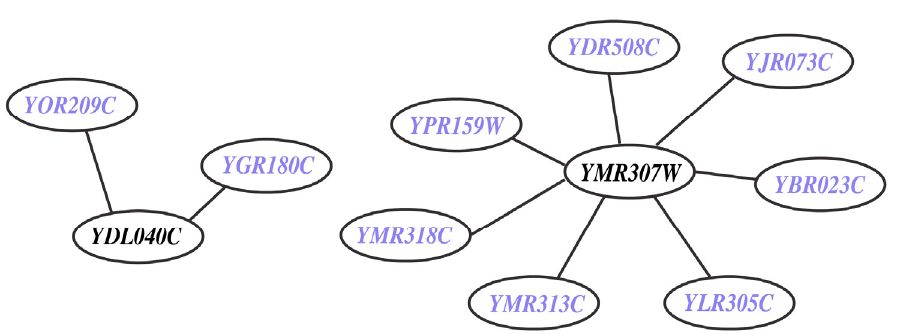
Figure 7. In vivo lethal gene pairs absent in model (MSL2 case). The genes YDL040C and YMR307W are involved in nine in vivo SL pairs but they are not present in Yeast 7.11 reconstruction. The participating genes (in blue) are found to be non-essential in silico